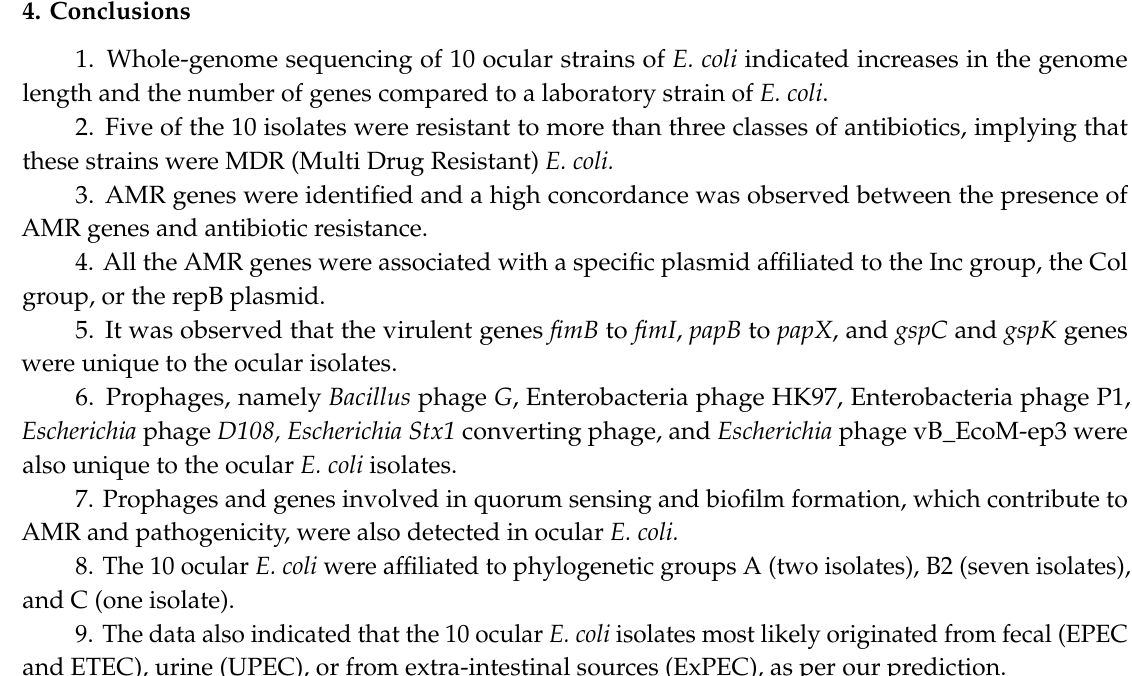
Table S1: Identification of probable tRNA genes* in the 10 ocular E. coli isolates. Table S2: Enrichment of genes* in the 10 ocular E. coli isolates. Table S3: Antimicrobial-resistant genes associated with the plasmids in the 10 ocular E. coli isolates. Table S4: Comparison of virulent genes in the 10 ocular E. coli isolates and E. coli type strains associated with phylogenomic groups A, B2, and C. Table S5: Comparison of virulent genes in the 10 ocular E. coli isolates and E. coli type strains associated with phylogenomic groups A to F. Table S6: Comparison of prophages in ocular, EPEC, ETEC, ExPEC, UPEC, and environmental E. coli strains. Table S7: Characteristics of patients from whom the 10 ocular E. coli isolates were collected. Table S8: Number of quorum sensing genes * in ocular E. coli isolates. Table S9: Biofilm genes * in ocular E. coli isolates. Table S10: Motility genes * in ocular E. coli isolates. Table S11: Characteristics of patients from whom the 10 ocular E. coli were